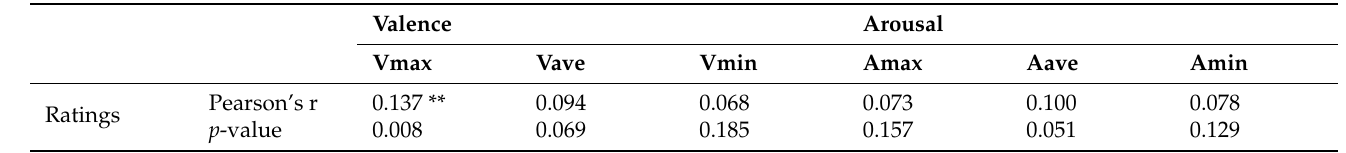
Table 8. Two-tailed Pearson’s r correlations between ratings and six calculated emotional percep- Table 8. Two- tailed Pearson’s r correlations betwee n ratings and six calculated emotional percep- tion tion results.